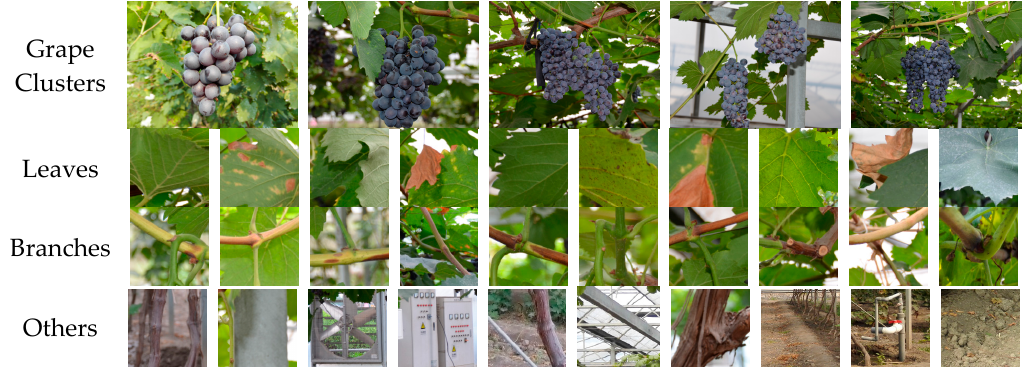
Figure 2. Examples of the dataset images. The top row listed the images of grape clusters captured under different lighting conditions, and the lower rows were background including leaves, branches, and other obstacles in the